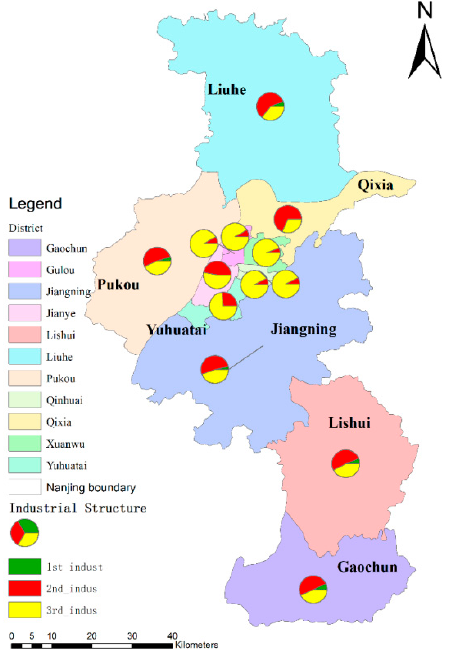
Figure 8. The spatial distribution of industrial structure of each district in Nanjing.